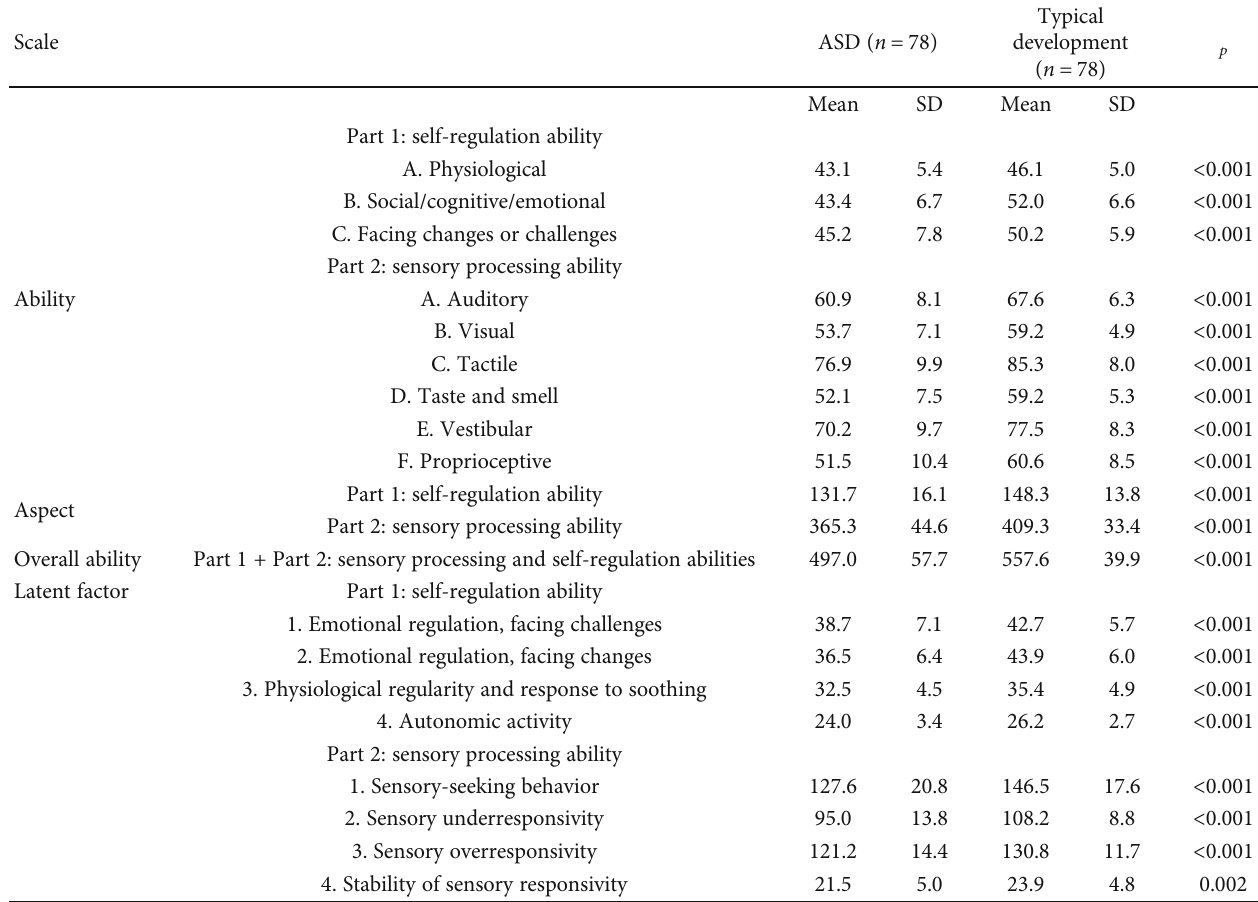
Table 3: Comparison of the scale scores of SPSRC checklist categories between typically developing children and children with ASD.